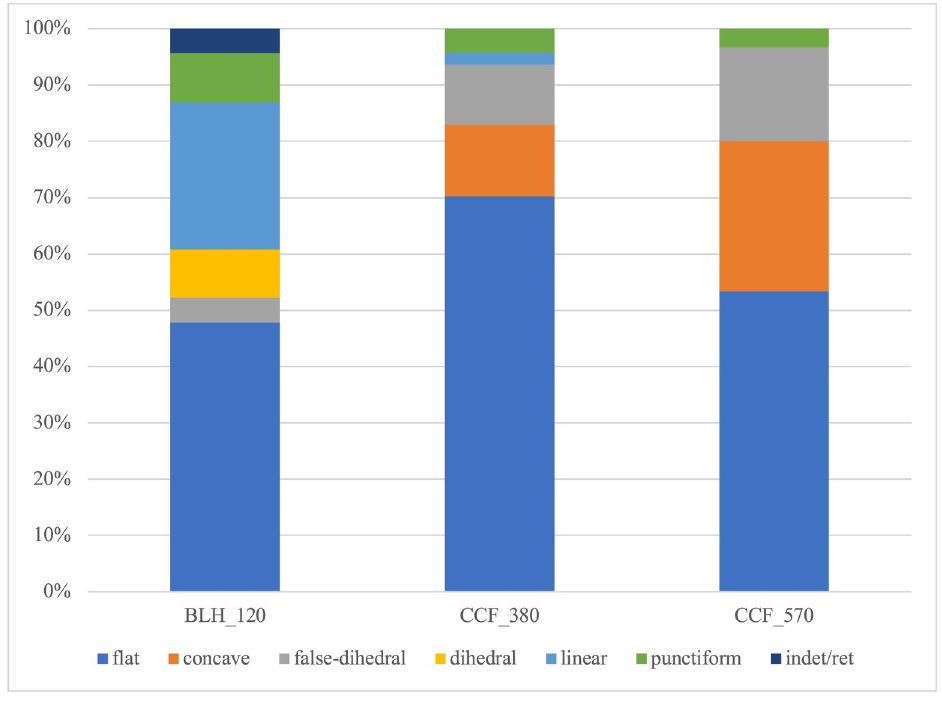
Fig 5. Frequency of butt types per